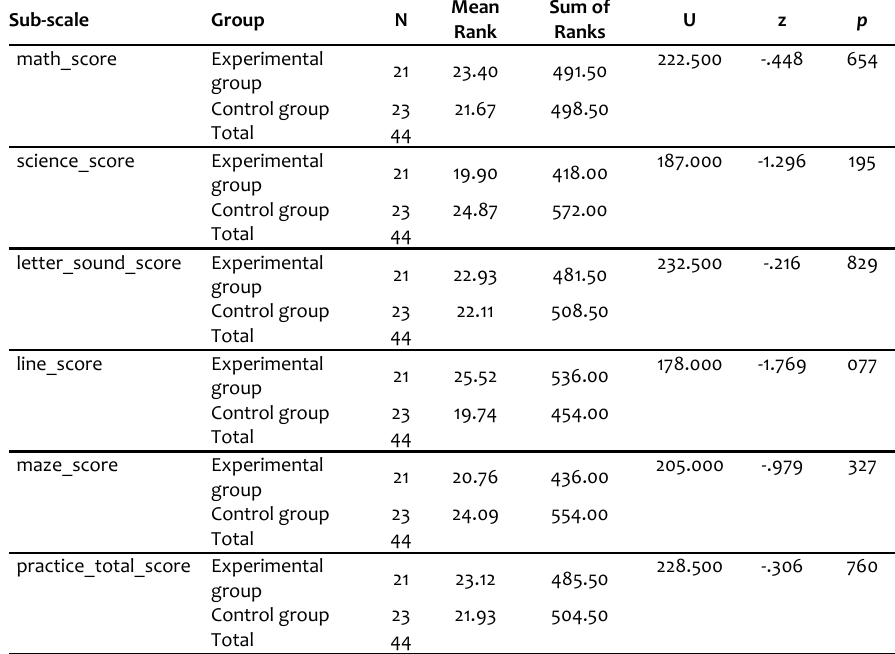
Table 1. Pre-test results of the practice scores in experimental and control groups Sub-scale